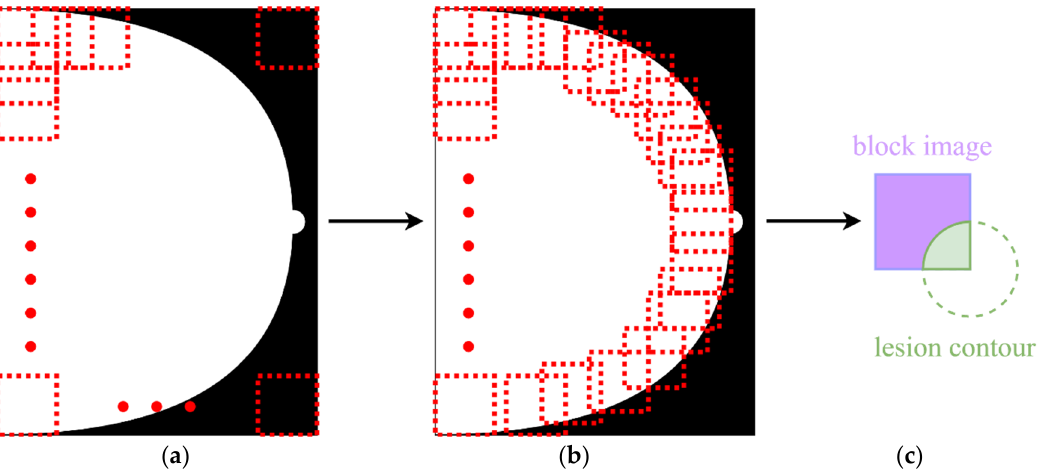
Figure 4. ( a ) Overlapping block images, ( b ) those of ( a ) selected as training data, and ( c ) a BI-RADS category assigned to each block image in ( b ). Table 3. Numbers of training and test